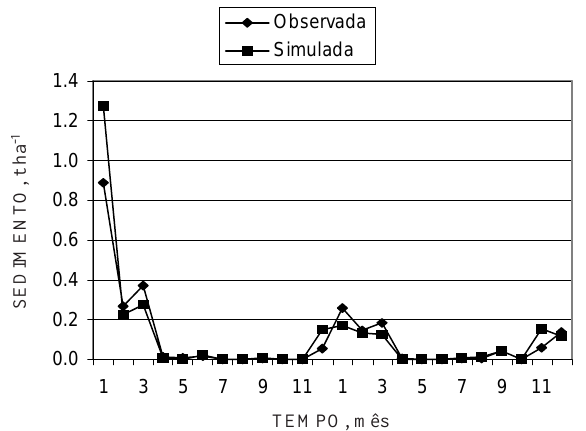
Figura 2. Produção de sedimentos observada e simulada no período 1999-2000, para a